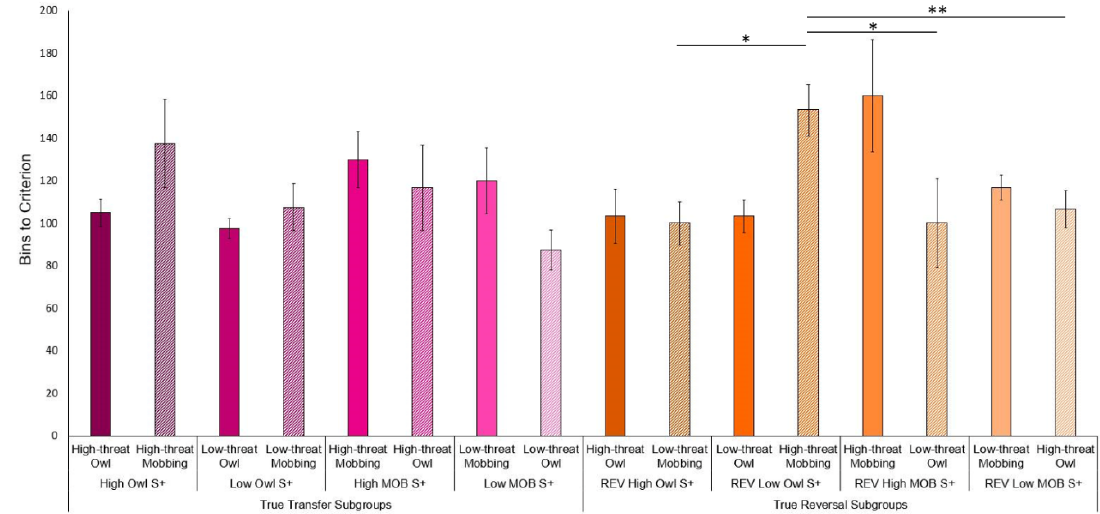
Discrimination Training II vs. Discrimination Training I: True Groups